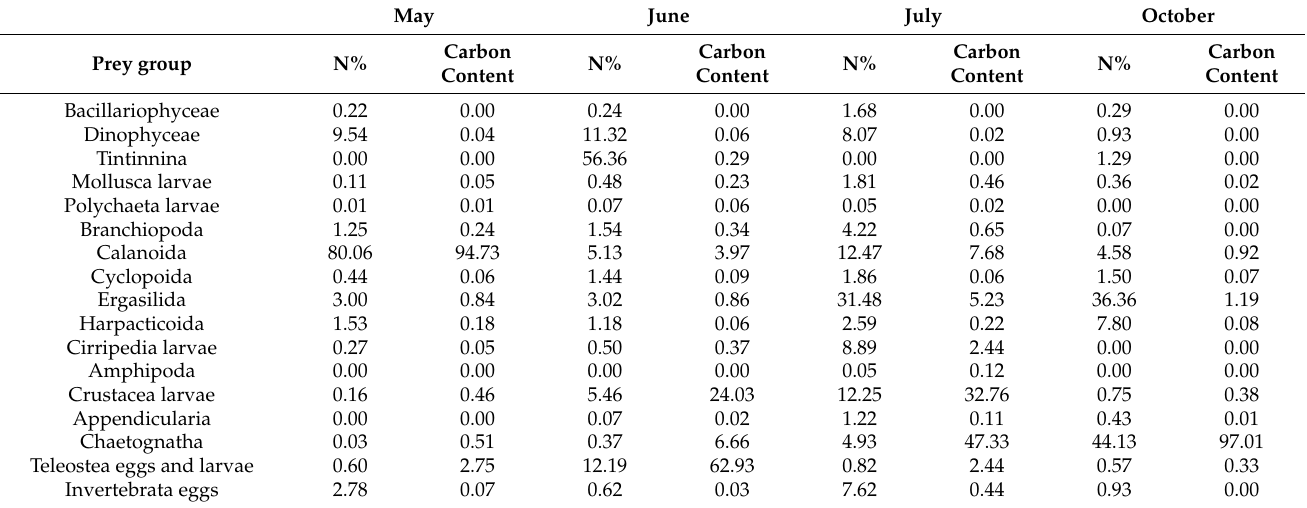
Table 4. Composition of Sardina pilchardus diet expressed as prey percentage on numerical (N%) and carbon basis, in May, June, July and October